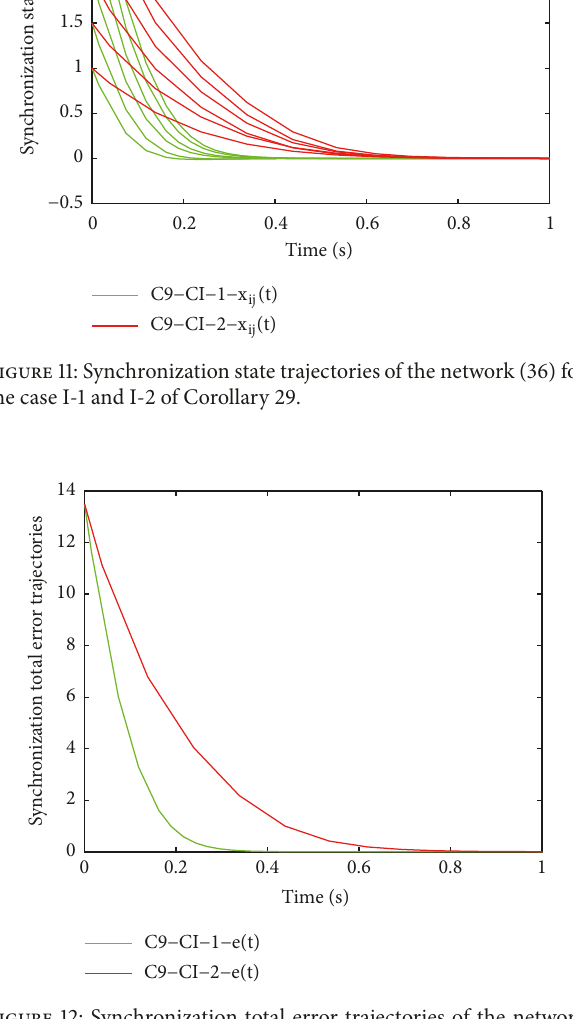
Figure 12: Synchronization total error trajectories of the network (36) for the case I-1 and I-2 of Corollary